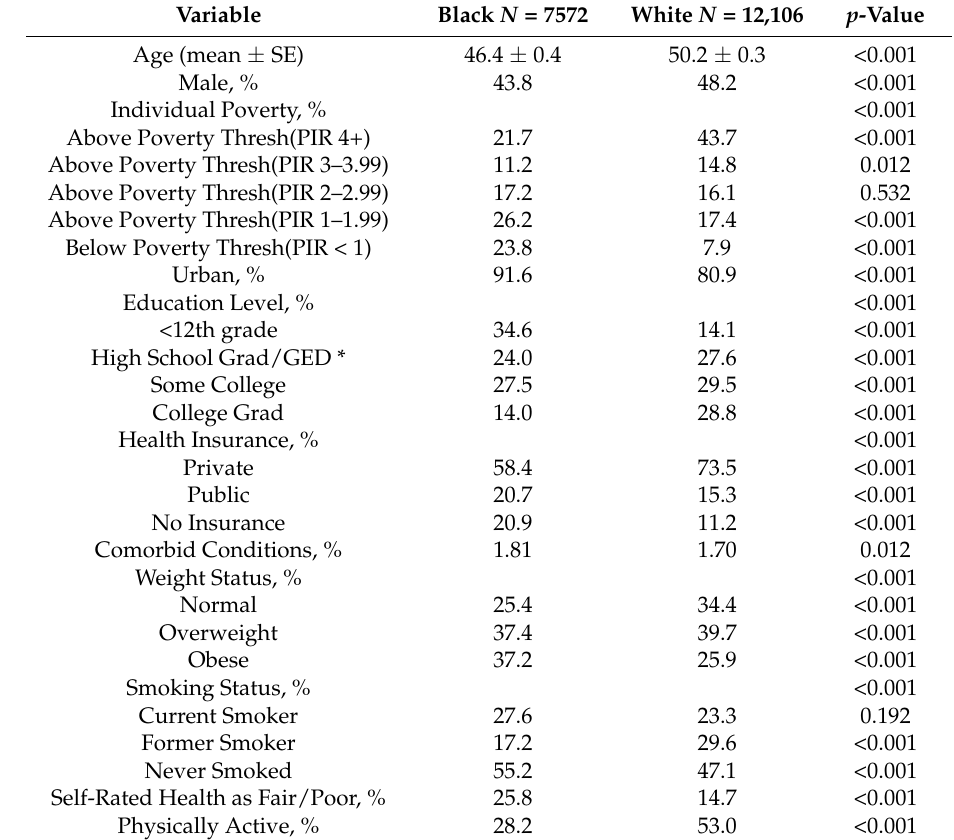
Self-Rated Health as Fair/Poor, % <0.001 Physically Active, % 28.2 53.0 <0.001 * GED stands for general education